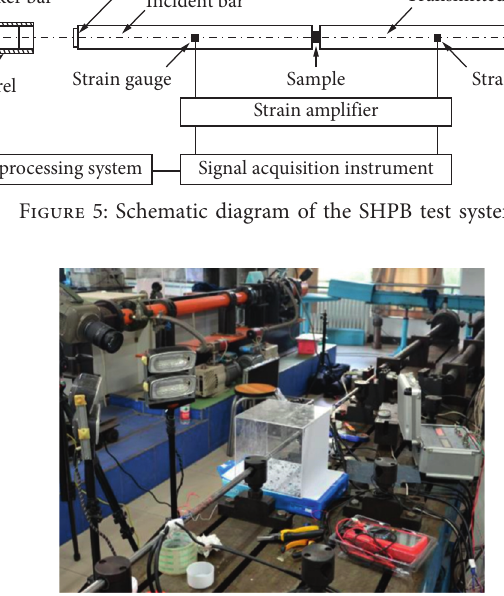
Figure 6: Experimental setup of SHPB.